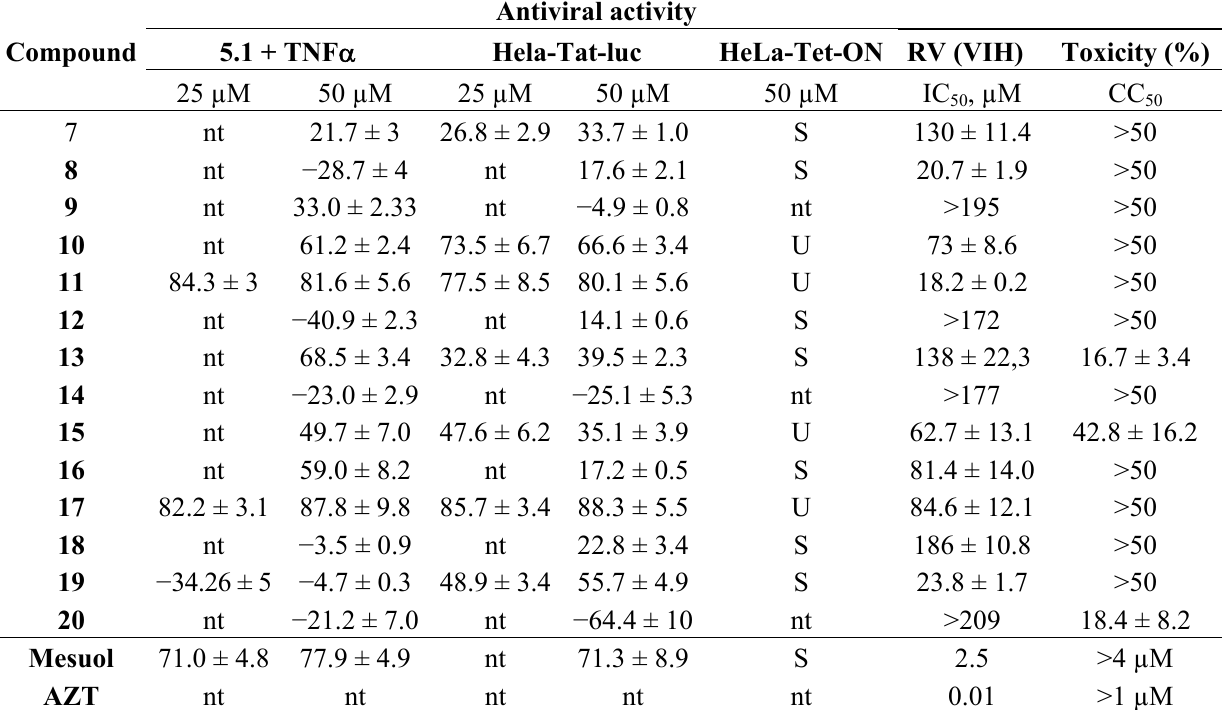
Table 1. Results of in vitro anti HIV-1 evaluation of 3-phenylcoumarins.